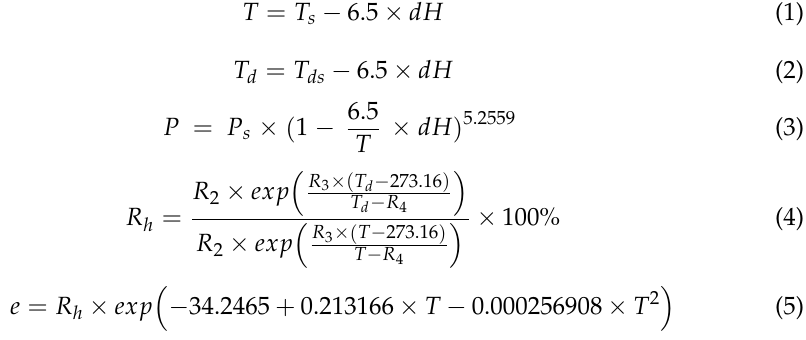
Calculating ERA5S-ZTD by the model method from T , P and e . These meteorological parameters are substituted into the Saastamoinen model [5], and then ERA5S-ZTD values of the IGS stations are obtained using the following equations.